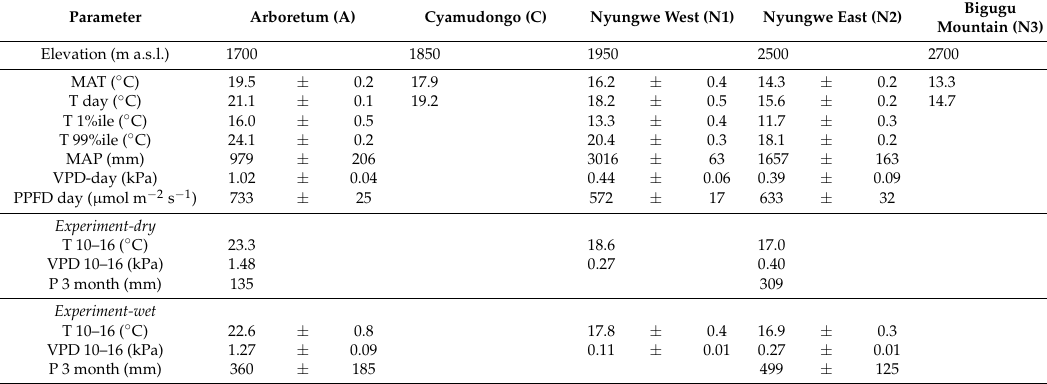
360 ± 185 ± 125 MAT and MAP at A, N1 and N2 are based on 4 years measurement (June 2013–May 2017), except MAP at N2 which was based on 2 years measurement (June 2013–May 2015). MAT at C and N3 are scaled from 6 weeks